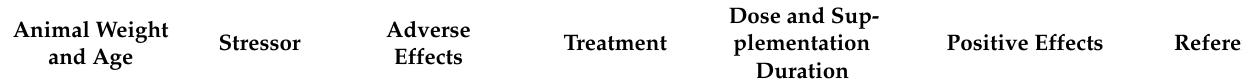
Table 1. Some examples of the effect of peptide/amino acid supplementation on piglets’ small intestinal